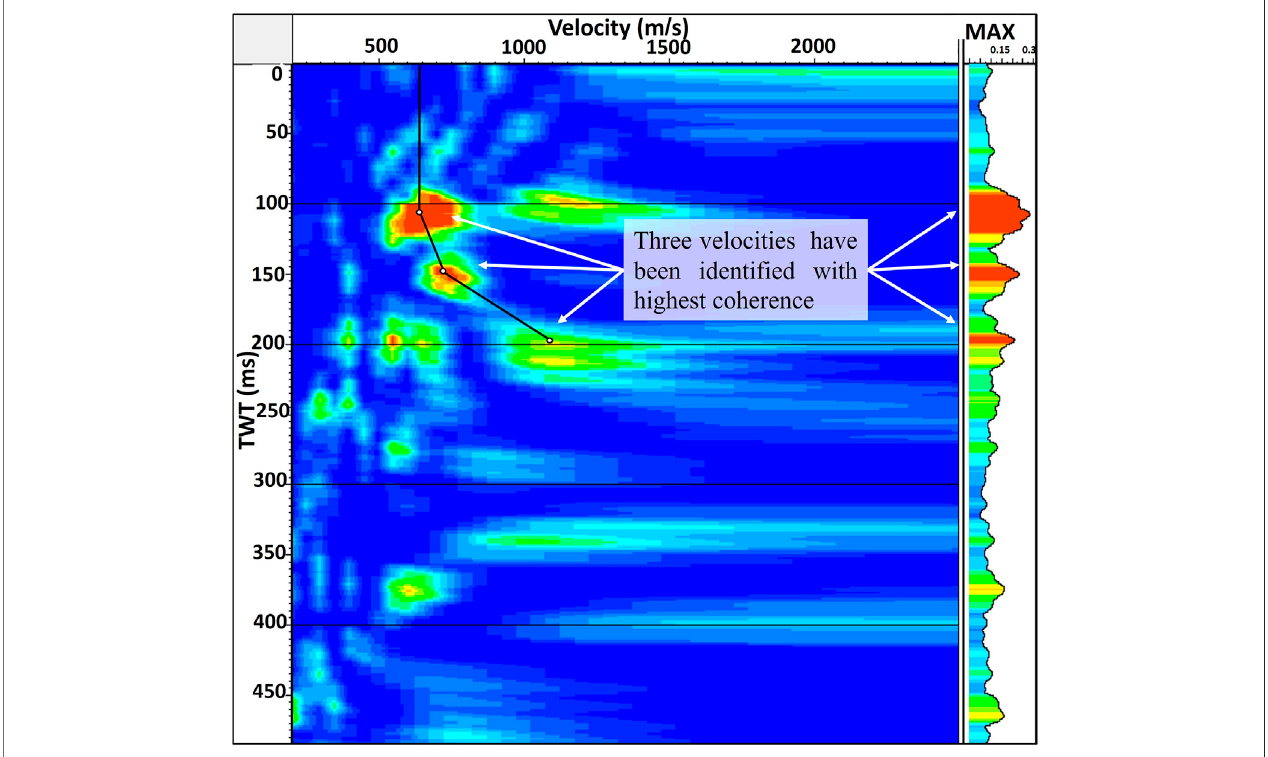
FIGURE 4 | An example of three velocities picking for CMP gathers on a semblance plot with the maximum coherence values (red color).